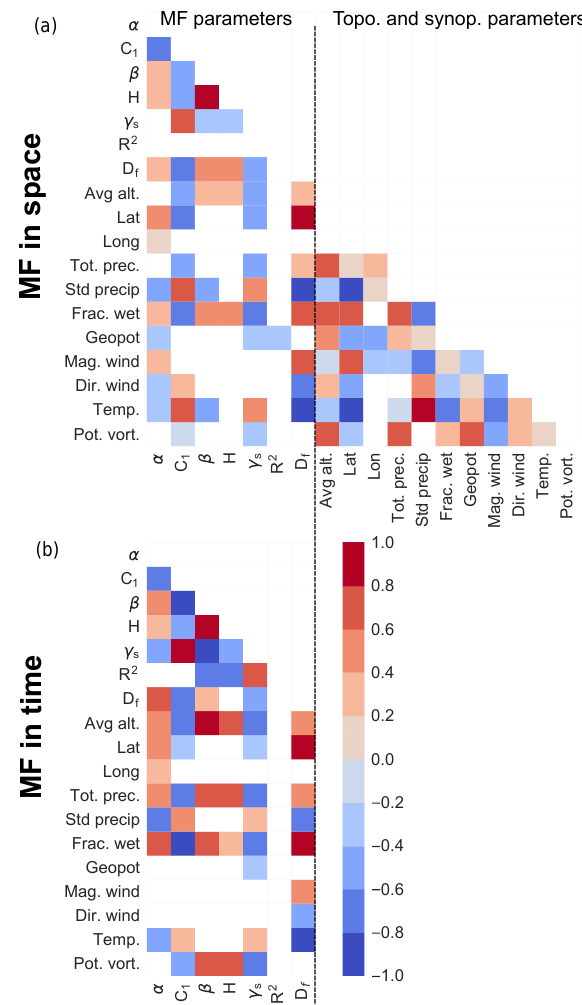
vort.Temp.Dir. Pot. H s R 2 D f Figure 3. Correlation plots showing the Spearman (rank) correla- tion between MF parameters and descriptors. (a) MF parameters estimated in space and (b) with MF parameters estimated in time. Note that the part on the right of the correlation plot in time has been truncated since it is the same as on the correlation plot in space. Cor- relations that are not statistically significant (for a significance level of 5%) and correlations which are not consistent in sign between time and space are left in